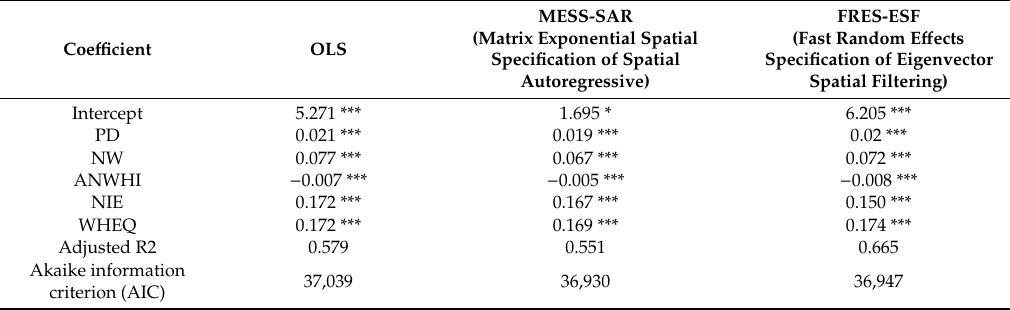
Table 4. Estimation results for the regression models